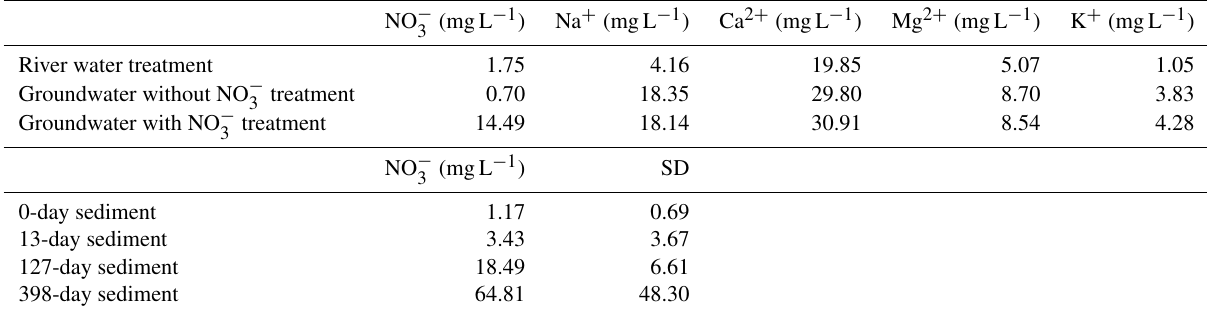
Figure 4. RR of untreated control samples and 0.5h inundated samples with black 1 : 1 line (a) , 0.5h inundated RR and days since inundation (b) , and 25h RR and days since inundation (c) . Note that in (a) 0 days since inundation RR (gray) plots along 1 : 1 line, but upper-elevation inundated RR does not co-vary with uninundated RR. Note that in (b) and (c) the x axis is plotted as a log scale. Table 2. Nitrate concentrations from untreated sediment (mean and standard deviation; uncorrected for grams of dry sediment) and nitrate and anion concentrations from treatment